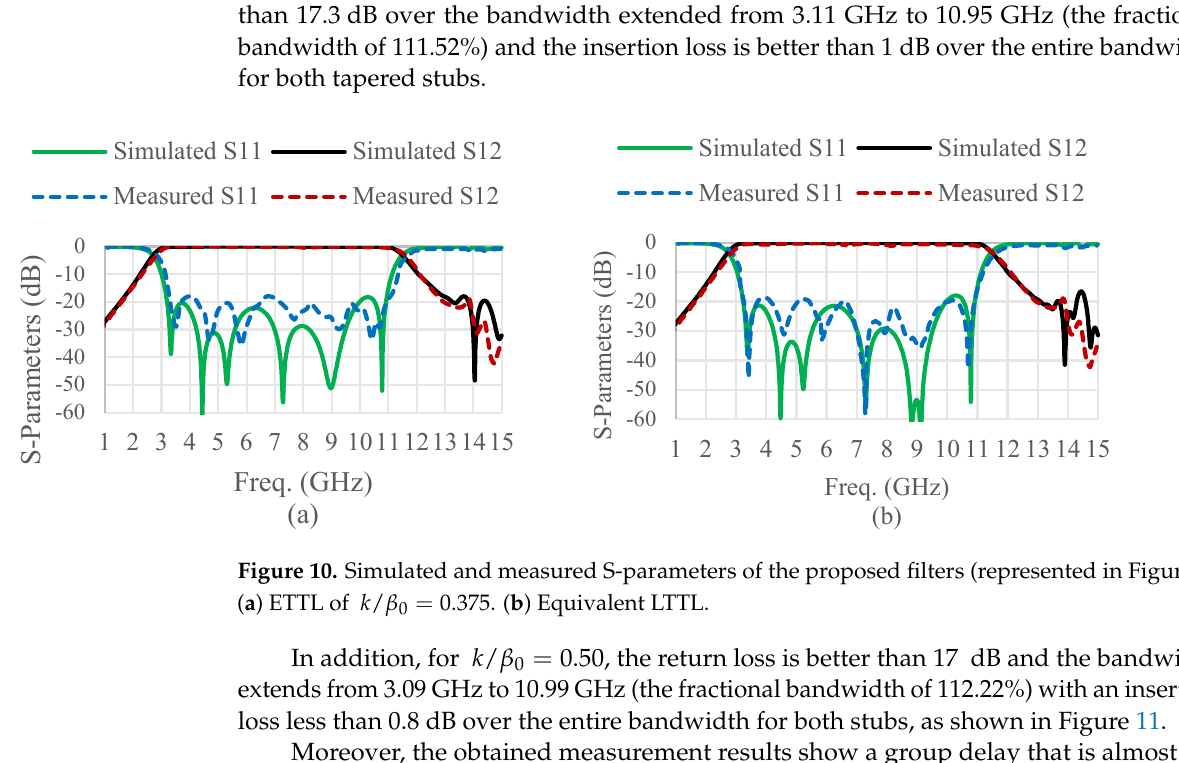
Figure 11. Simulated and measured S-parameters of the proposed filters (represented in Figure 6). ( a ) ETTL of 𝑘 𝛽 (cid:2868) = 0.50⁄ . ( b ) Equivalent LTTL. Table 3. Equivalent lumped elements.